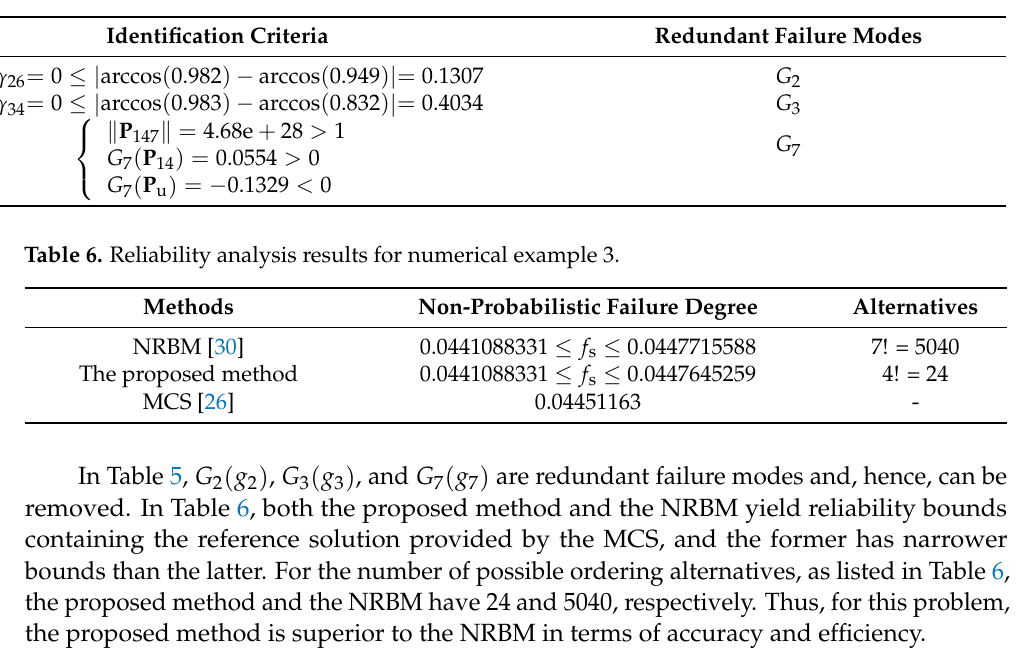
Table 5. Redundant failure modes and identification criteria for numerical example 3.